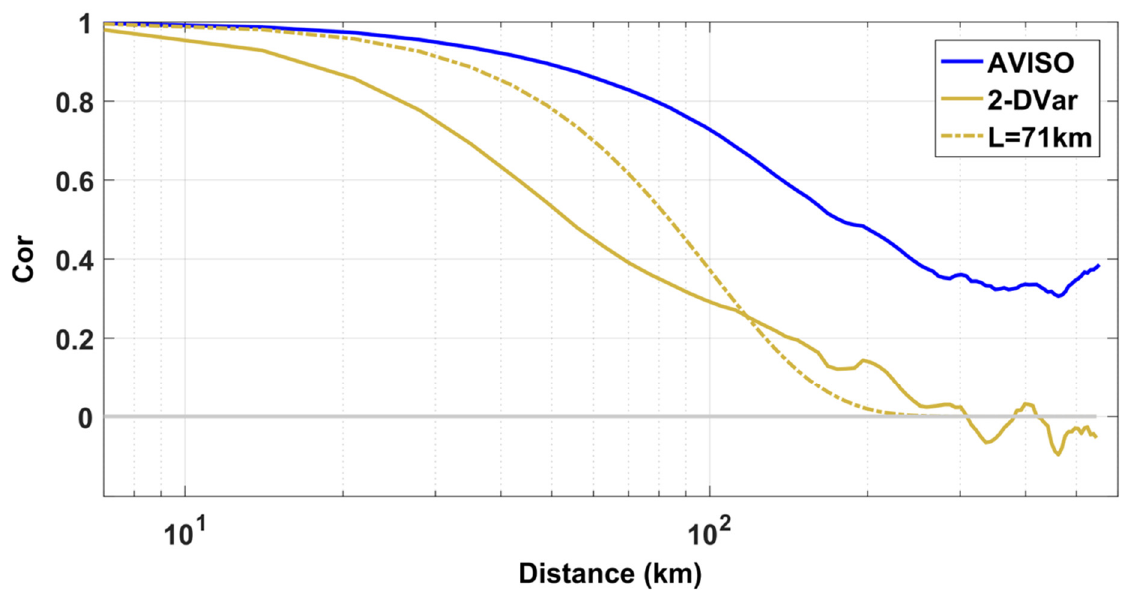
Figure 2. Relationship between background error correlation and distance. The solid blue and yellow lines represent AVISO and 2-DVar, respectively. The dashed yellow line denotes the Gaussian distribution e − r 2 /2 L 2 by fitting 2-DVar with its correlation coefficient scale L of 71 km.